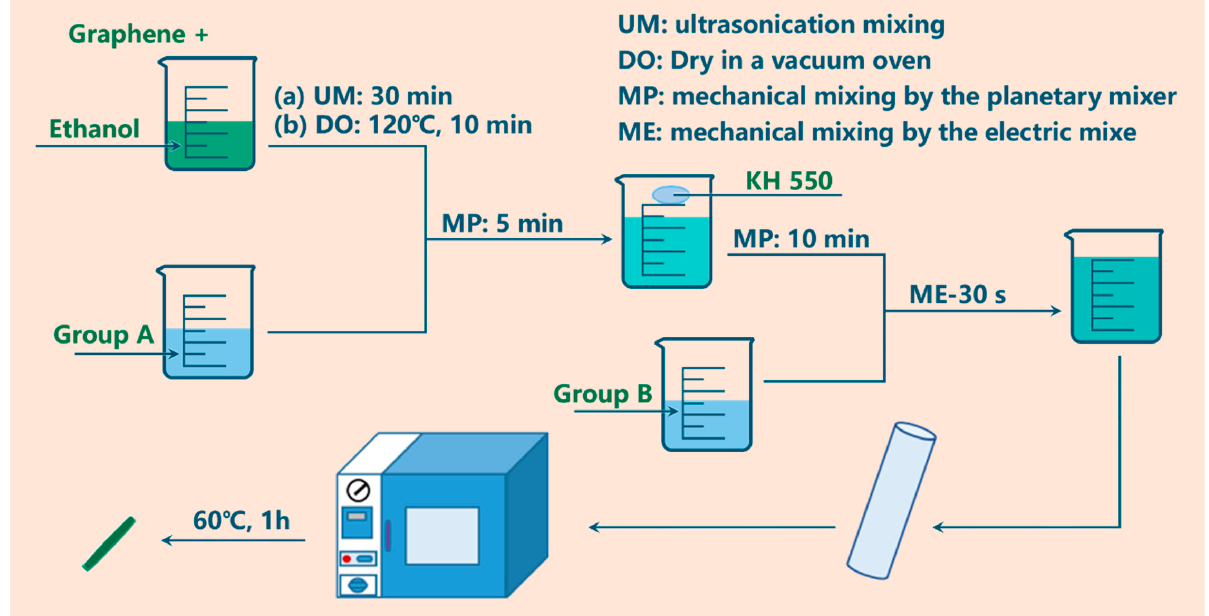
Figure 1. Preparation process of silicone rubber foam/graphene (SR/Gr) composites.